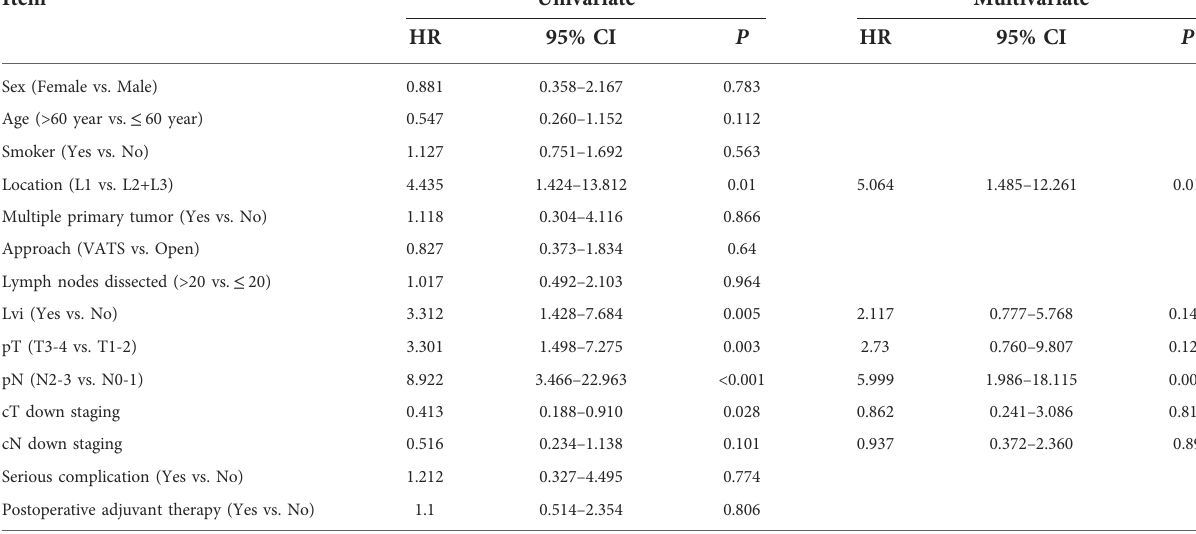
TABLE 3 Results of univariate and multivariate analyses of risk factors for PELLNR in ESCC patients with neoadjuvant therapy. Item Univariate Multivariate